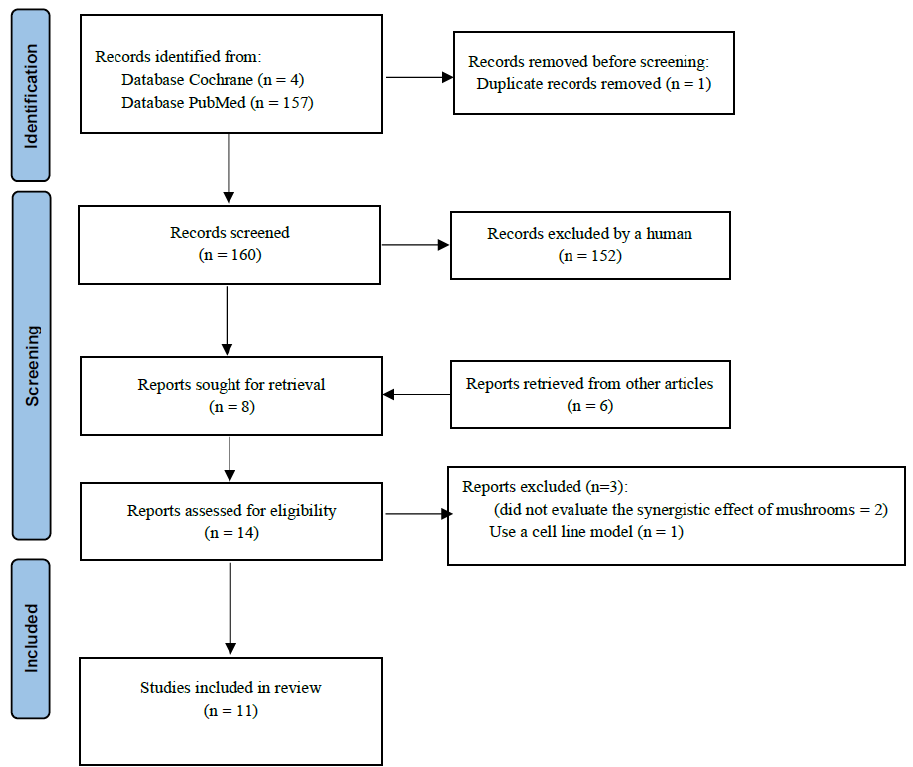
Figure 1. PRISMA diagram of the literature selection in this narrative review.